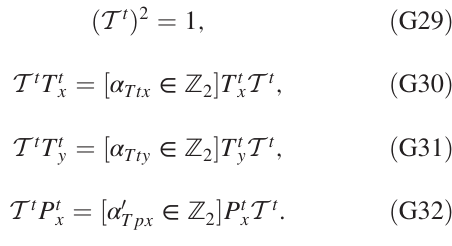
TABLE II. Set of eight projective representations whose cohomology